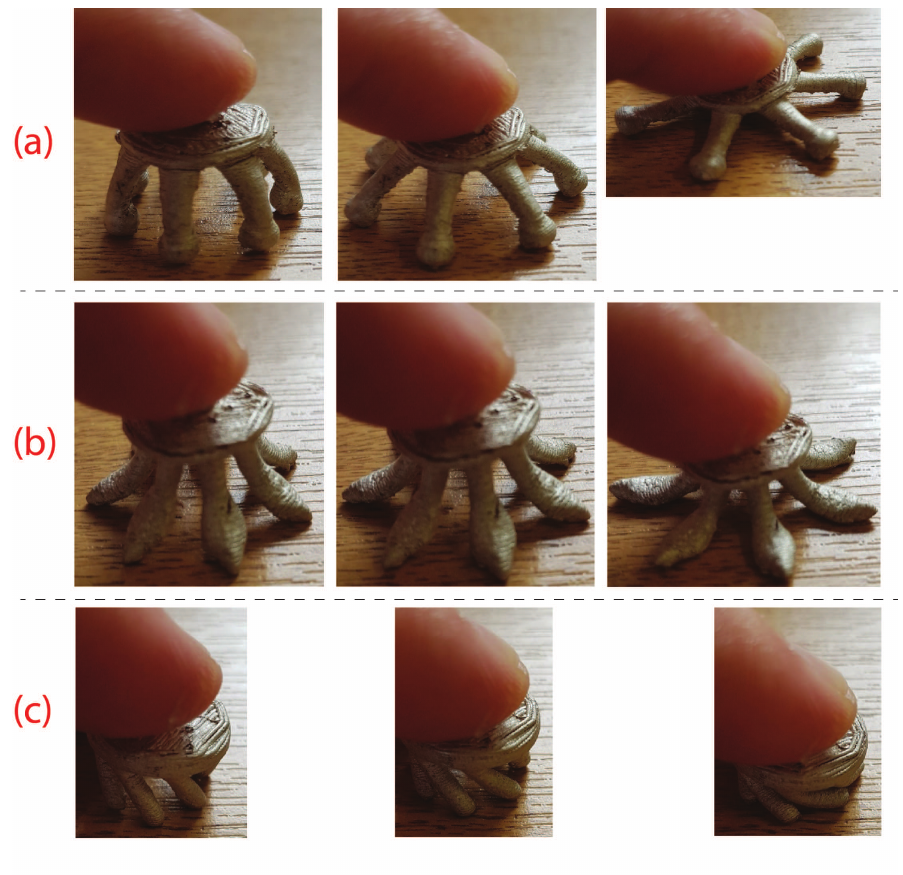
Figure 9. Physical deformations of the different electrodes when pressed against a fixed surface show the different shapes in which the fingers spread. ( a ) Spider electrode. ( b ) Anti-spider electrode. ( c ) Spiny